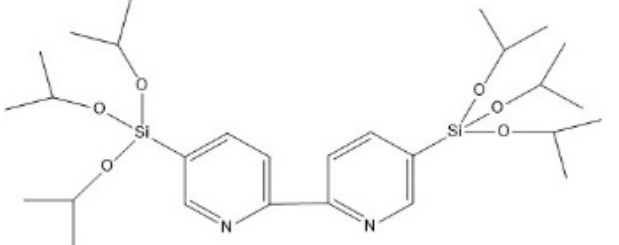
Figure 7. Chemical formula of the 5,5′-bis(triisopropoxysilyl)-2,2′-bipyridine (iPrbipy) precursor.